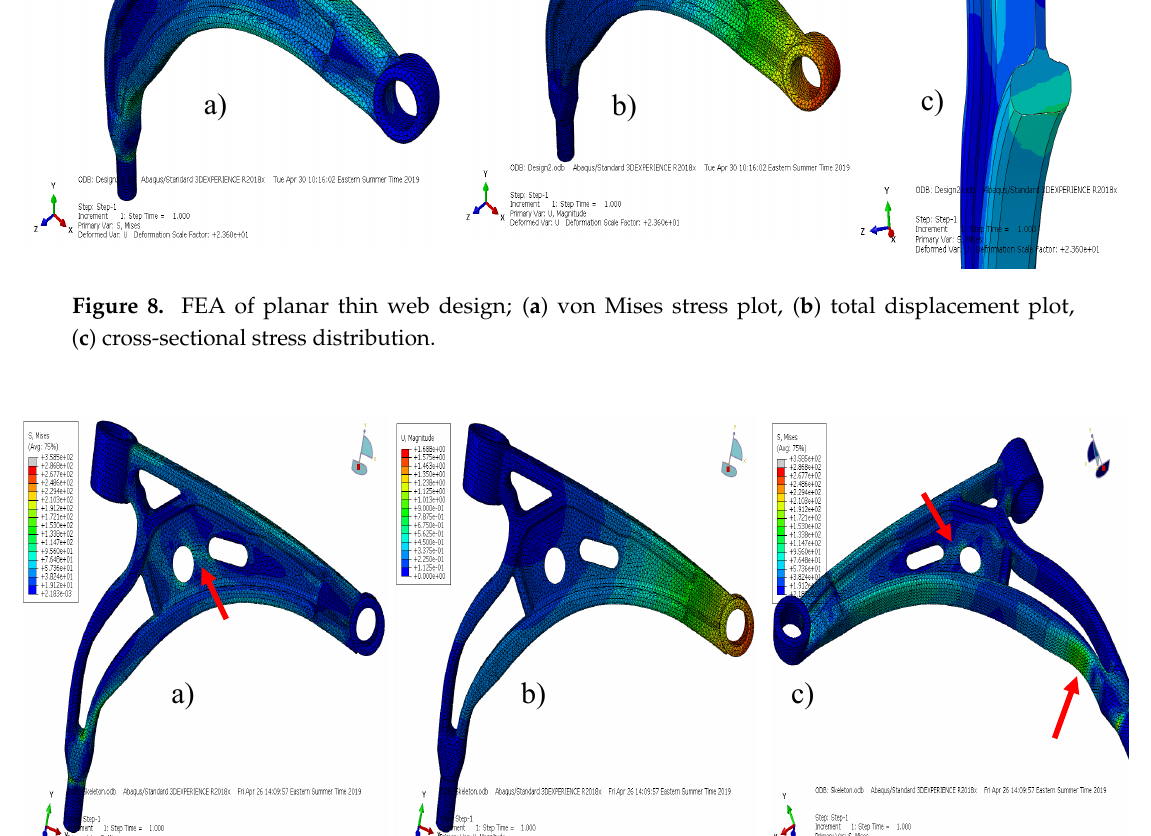
Figure 10. FEA of trussed design; ( a ) von Mises stress plot, ( b ) total displacement plot, ( c ) other view of Von Mises (VM) stress plot. Tble 2. Finite element (FEA) results obtained for the applicable parts with various designs proposed.